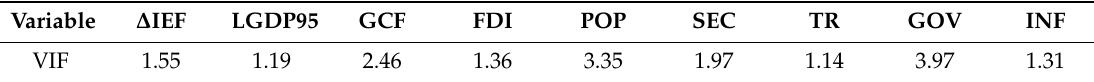
Table 7. Multicollinearity test (VIF values).